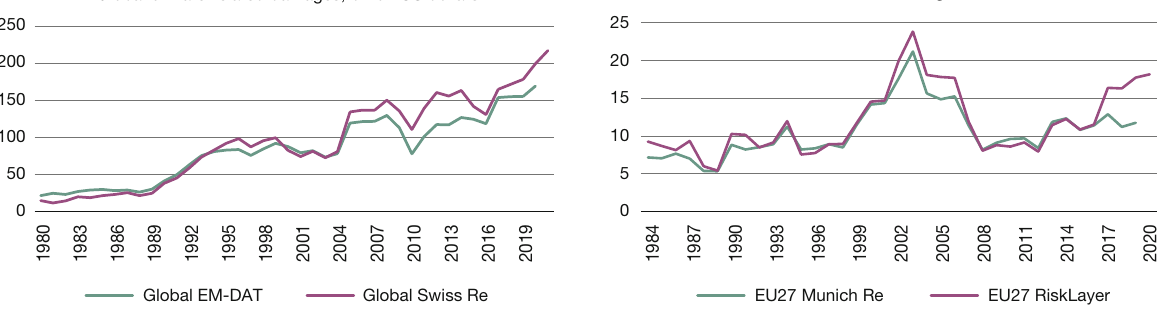
Historic damages from climate-related natural events worldwide and in the EU Five-year moving averages